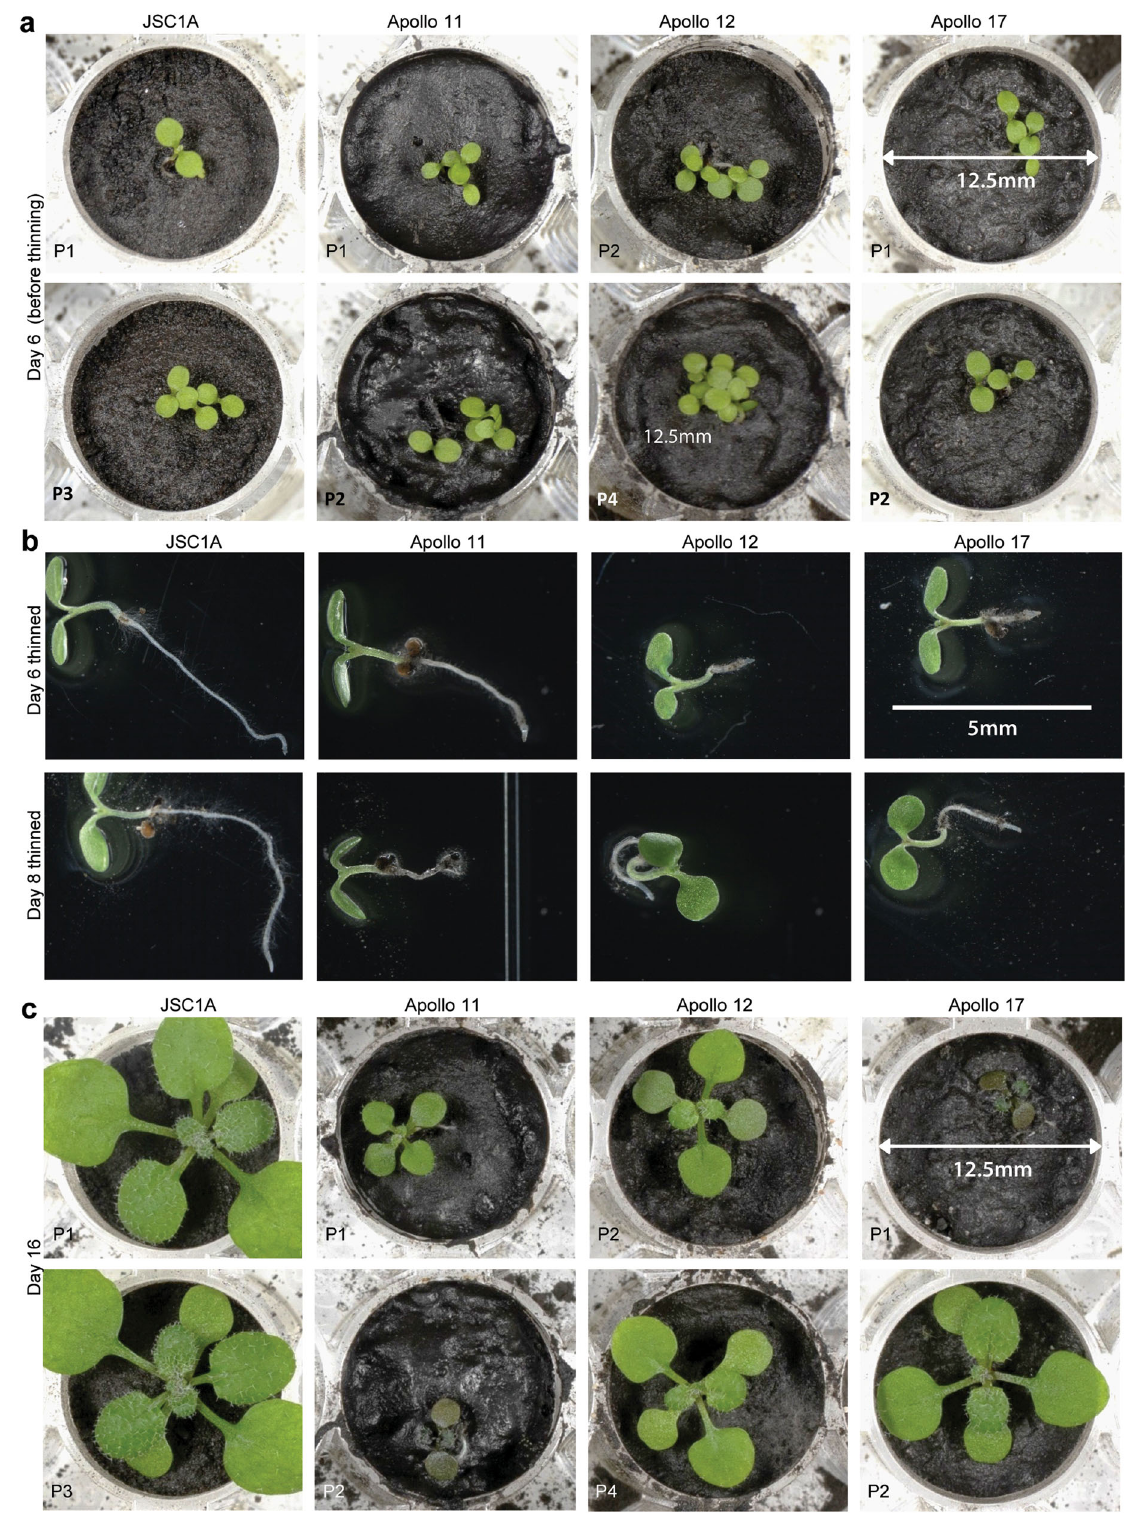
Fig. 2 Germination and development in the lunar regolith. a Germination rates were close to 100% in all sources of Apollo lunar regolith and indistinguishable from rates in JSC-1A simulant. Two representative wells for JSC-1A and each Apollo site are shown. b The seedlings thinned from each well on day 6 or 8 indicated that root growth in lunar regolith is not as robust as in JSC-1A. c While germination was uniform among controls and lunar sites, the lunar regolith-grown seedlings did not thrive as compared to the JSC-1A controls. The diameter of the culture plate wells is 12.5 mm (scale bar provided in c ). All microscope images in b are shown to the same scale (scale bar shown in the Apollo 17